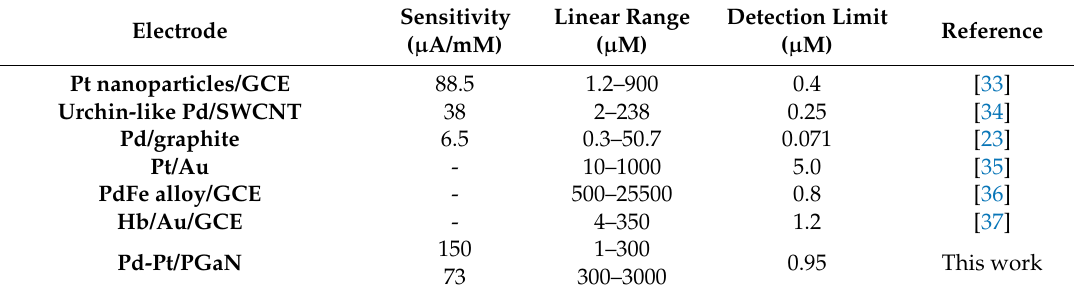
Table 1. Sensing performance compared to other electrode substrates for nitrite determination.